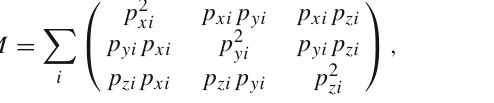
where i represents the i th jet in the event. The event is pencil- like when transverse sphericity S ⊥ → 0, while the event is sphere-like when S ⊥ →